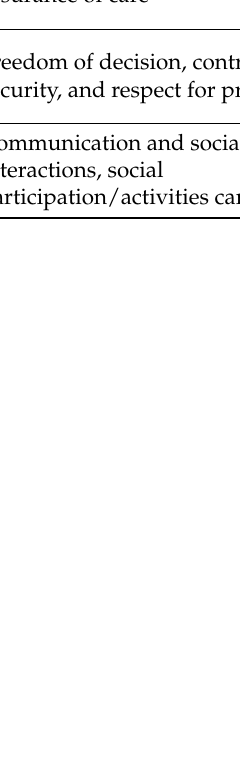
Table 2. Phases of data